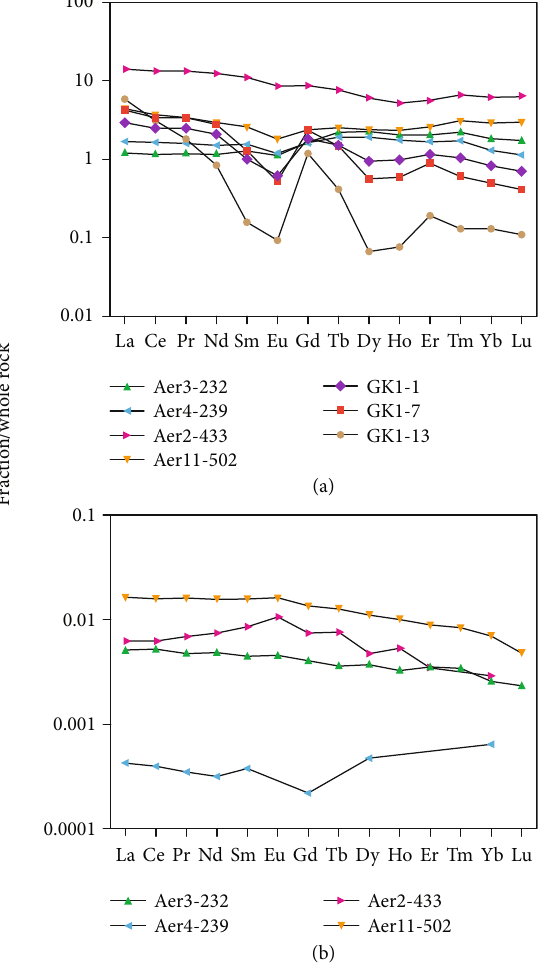
Figure 4: REE concentrations of isolated organic fractions ((a) kerogen and (b) extract fractions)) of mudstones normalized to corresponding whole rock.